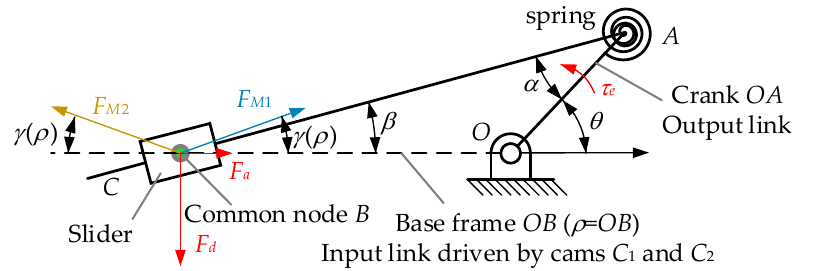
Figure 3. Static forces at the common node B.